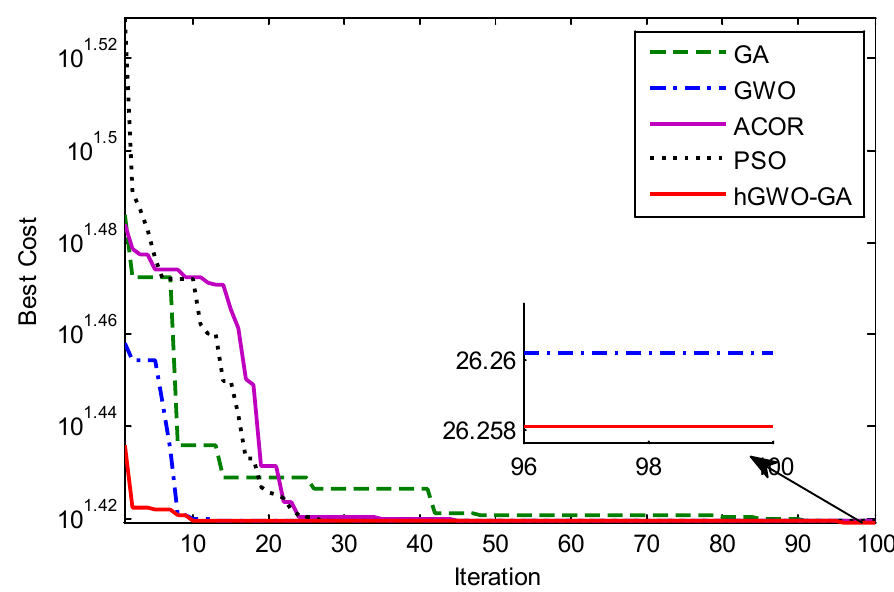
Figure 12. Fitness convergence for robust solution ( m-based stabilizer).